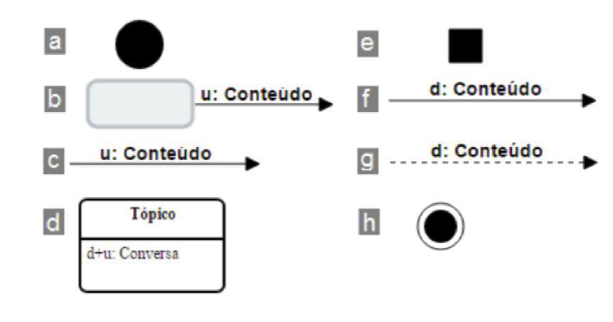
Figure 1. MoLIC 2nd version Elements (De Souza, Barbosa